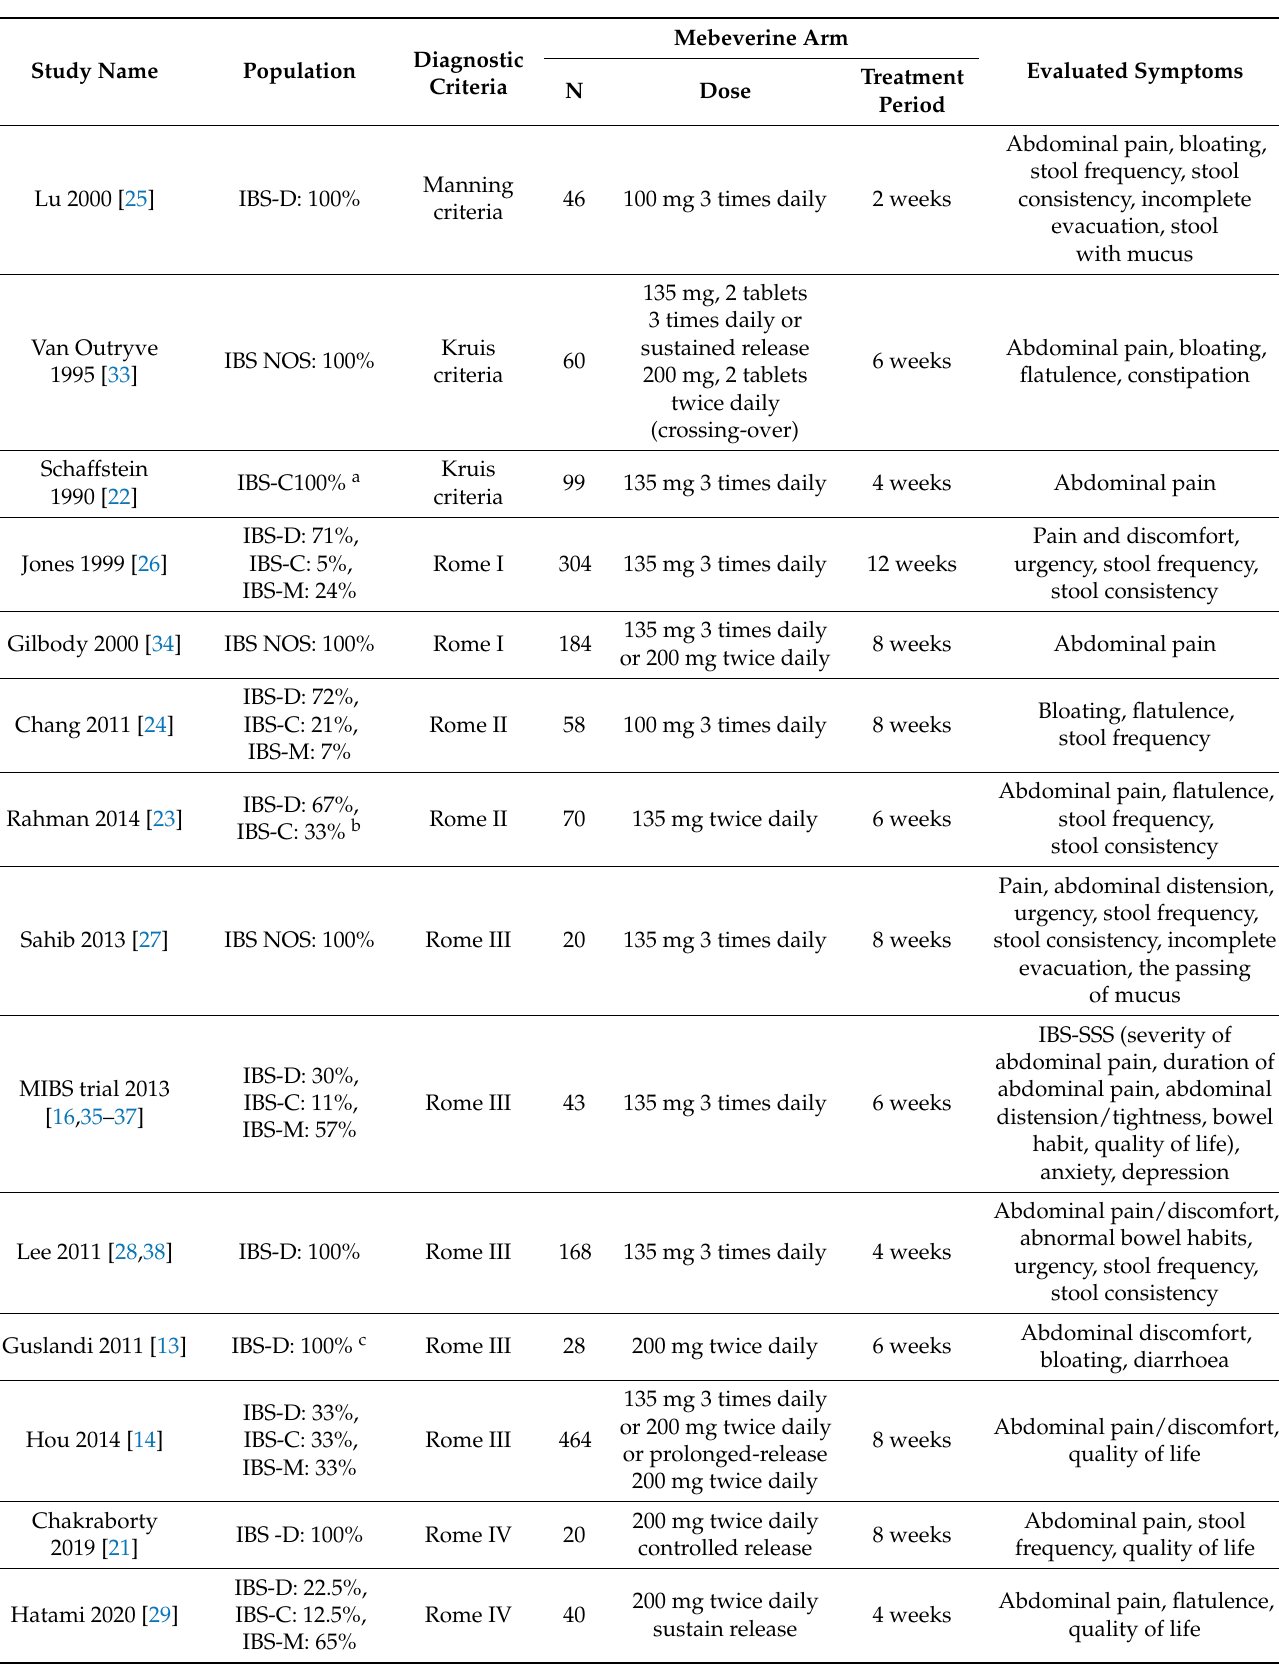
Table 2. Characteristics of the included